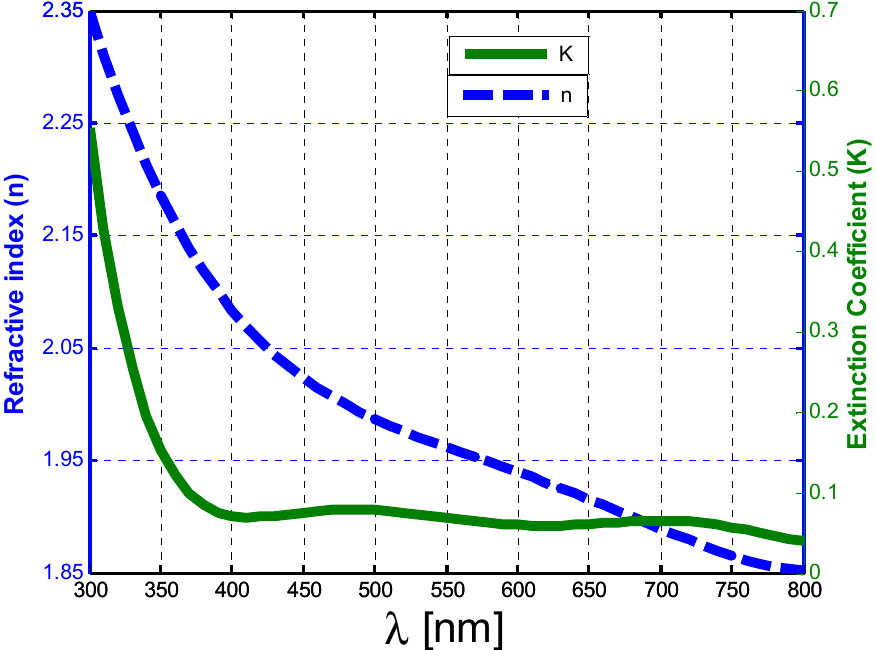
Figure 12. The refractive index and extinction coefficient of indium–tin–oxide (ITO) as a function of the incident wavelengths.